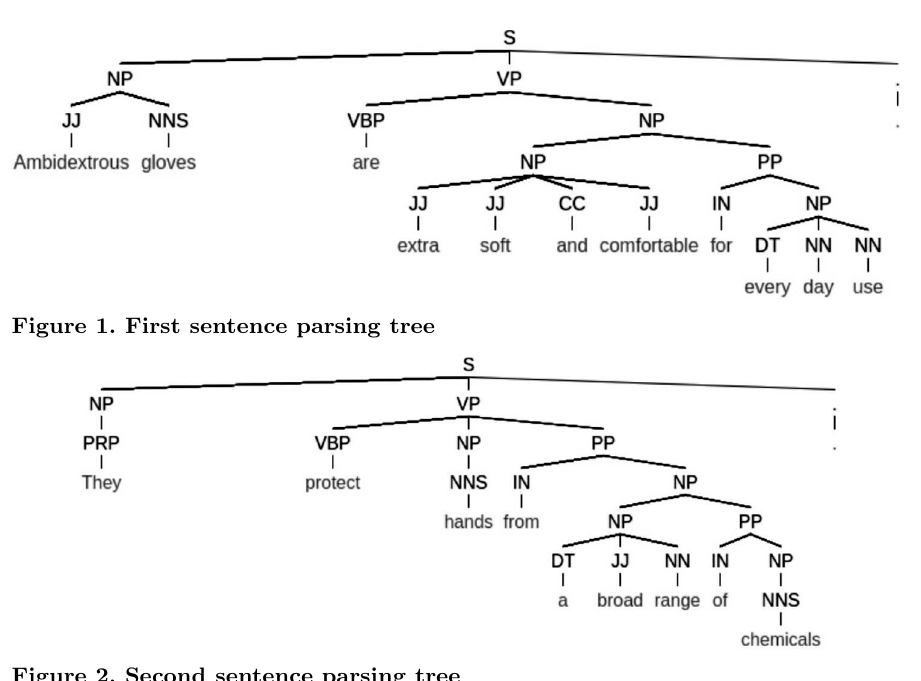
Figure 2. Second sentence parsing